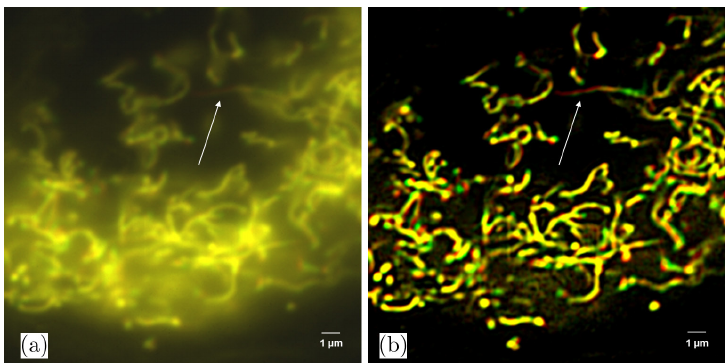
Fig. 9. Dynamic WF(a) and SIM(b) imaging of mitochondria in live Cos7. The images were rendered with di®erent colors from green to red correspond to time series. The colorful feature in (b) clearly demonstrates the movement of the